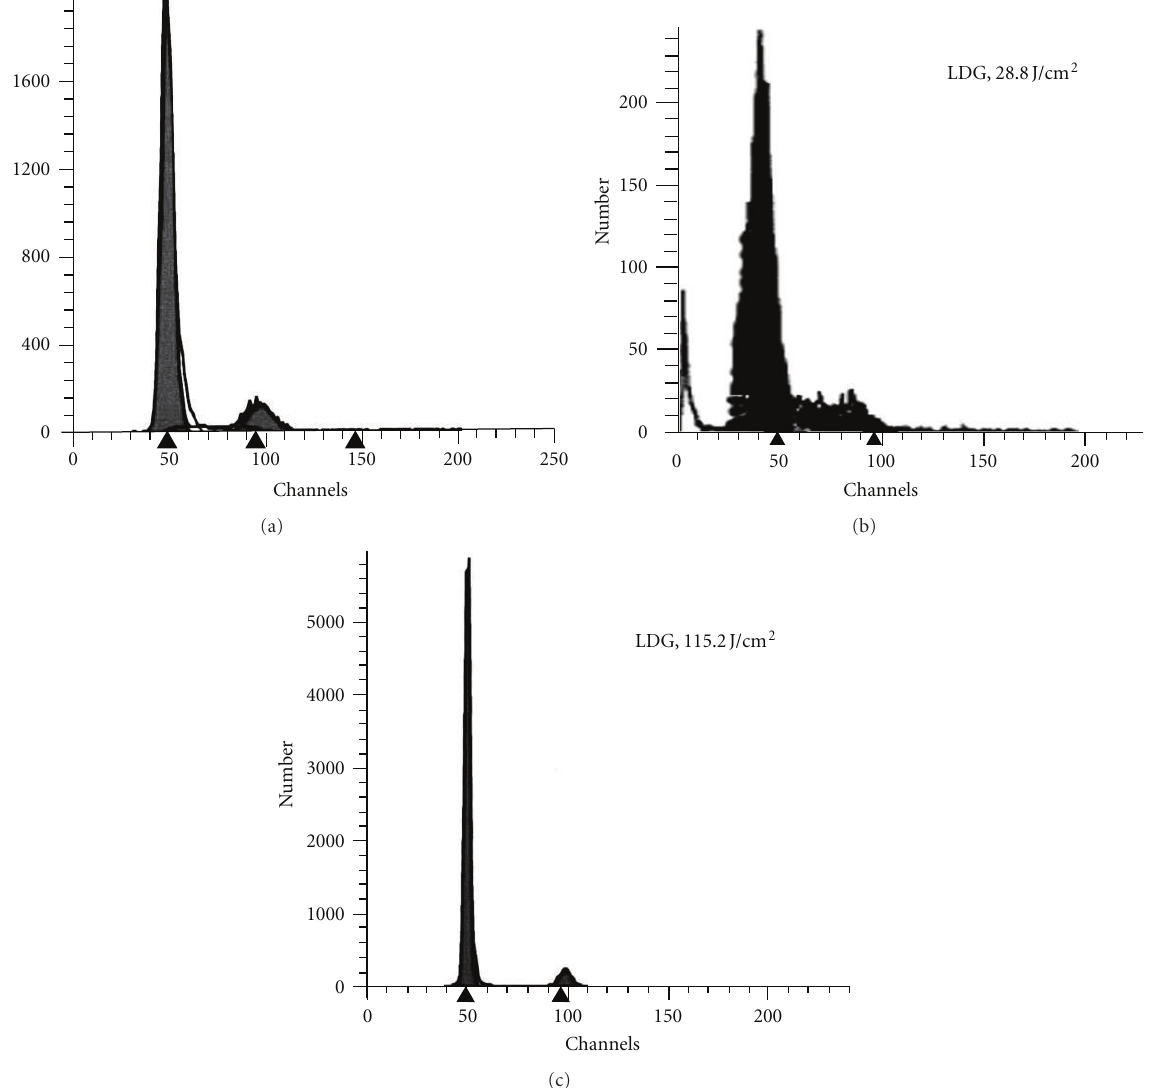
Figure 4: E ff ects of low-dose UVA on fibroblast cell cycle. PI staining using single parameter histogram represented the change of cell cycle in each group. DNA histogram o ff ered peak distribution. The ordinates represented cell number, and the abscissa represented PI intensity. The DNA peak near 50 (2C) in the abscissa represented the diploid G0/G1 phase; the DNA peak near 100 (4C) in the abscissa represented the tetraploid G2/M phase; the DNA peak between 2C and 4C represented diploid to tetraploid S phase; the DNA peak before 2C represented hypodiploid DNA fragments indicating cell apoptosis. (a) Phase distribution of cell cycle of SIG fibroblasts. The proportions of G0/G1 phase, S phase, and G2/M phase were 85.01%, 6.49%, and 8.49%, respectively. (b and c) Repeated low-dose UVA irradiation altered the phase distribution of cell cycle. When the dosage accumulated to 28.8 J/cm 2 , the proportions of G0/G1 phase, S phase, and G2/M phase were 84.09%, 12.95%, and 1.95%, respectively (b); when the dosage accumulated to 115.2 J/cm 2 , the inhibition of cell cycle was